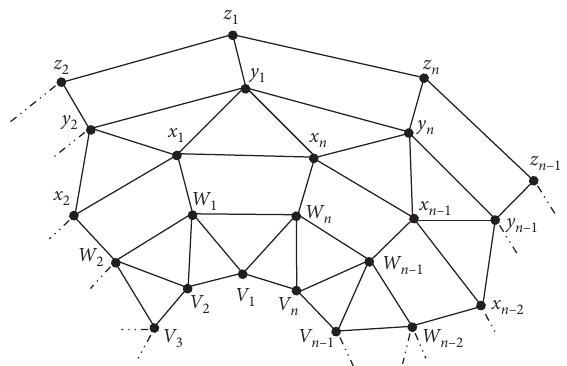
Figure 3: The graph of n -dimensional convex polytope K